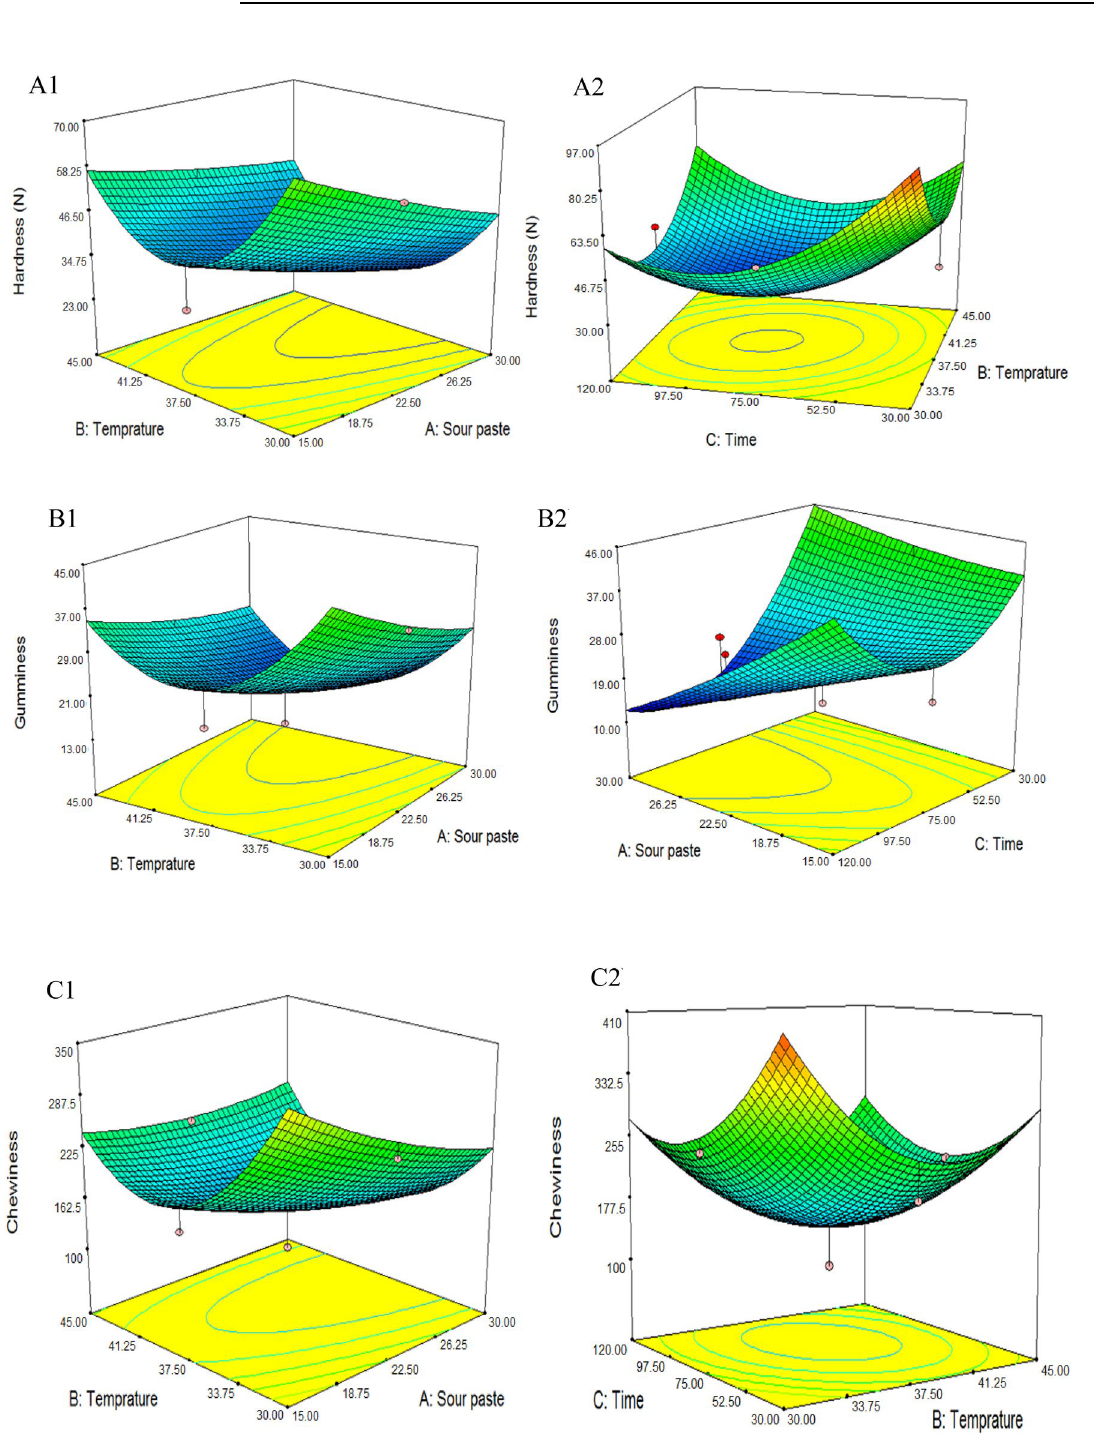
Fig.1 Effect of temperature and sourdough amount (1) and fermentation time and temperature (2) on textural properties (hardness a , gum- miness b , chewiness (C)) of Barbari bread